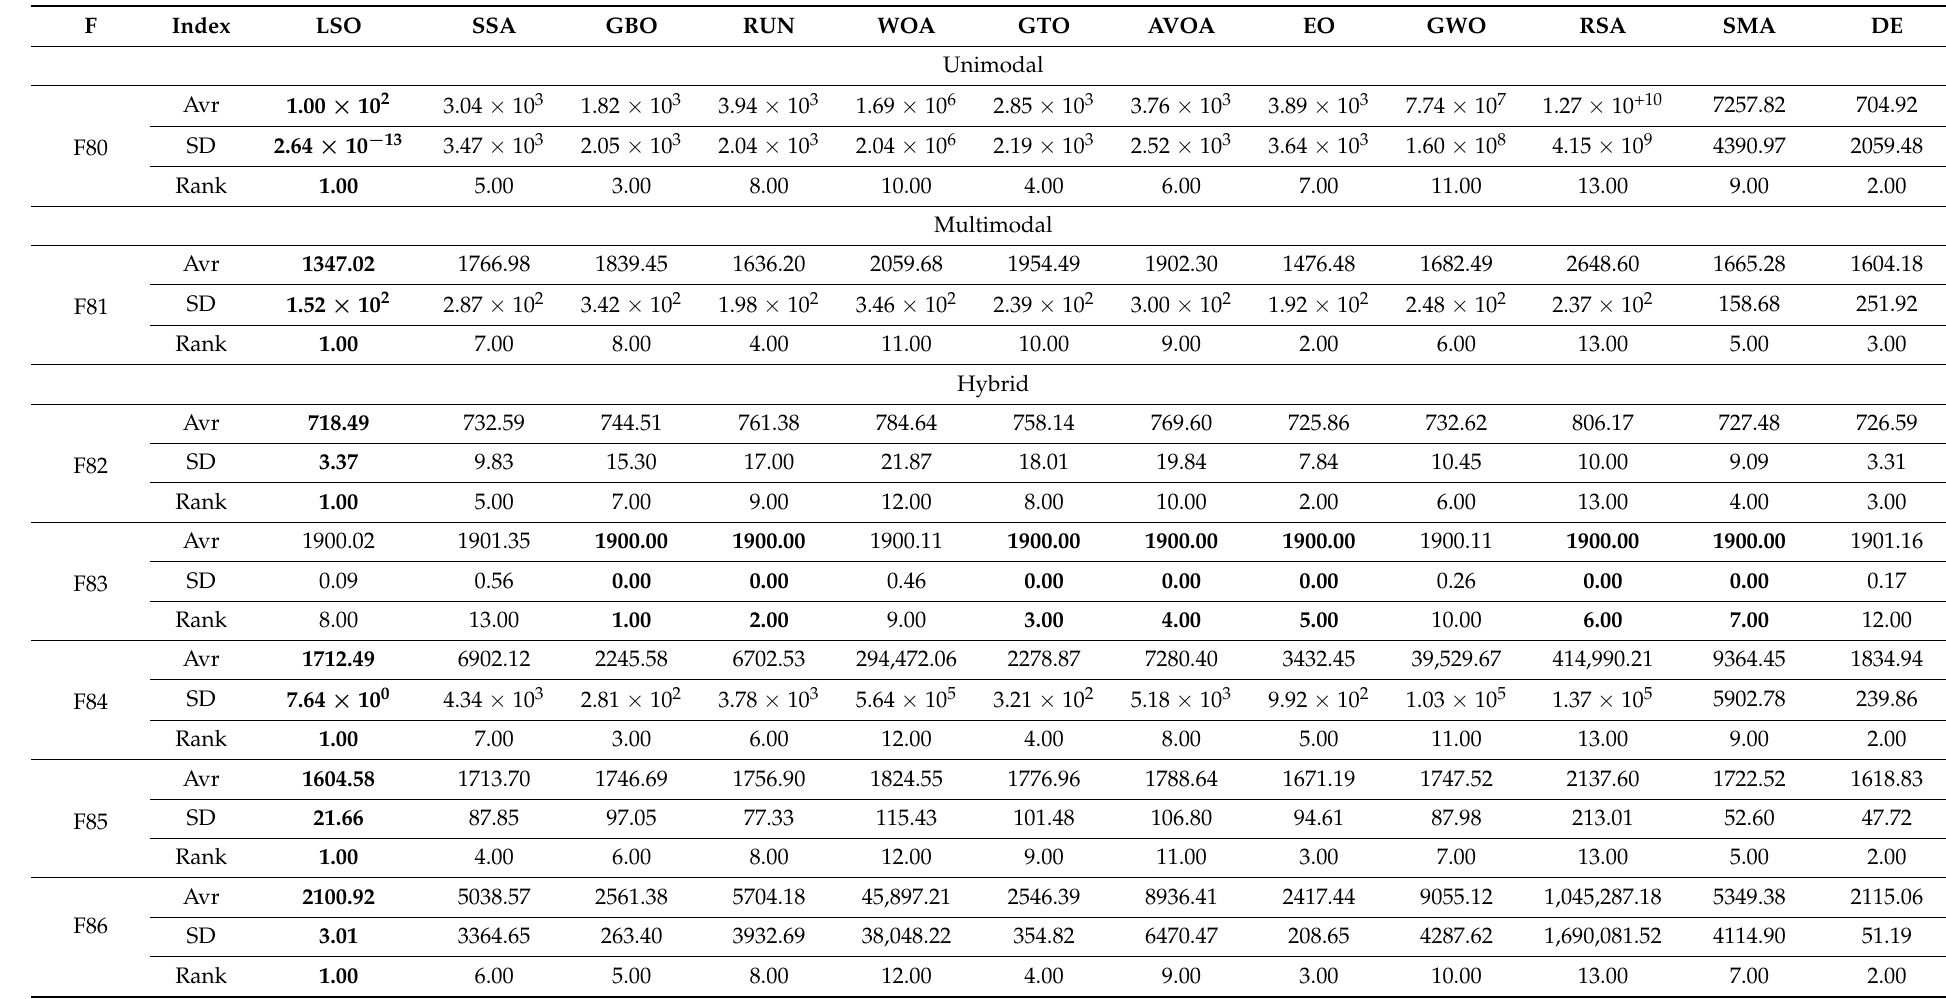
Table 12. Avr and SD of CEC2020 for 25 independent runs (The bolded value is the best